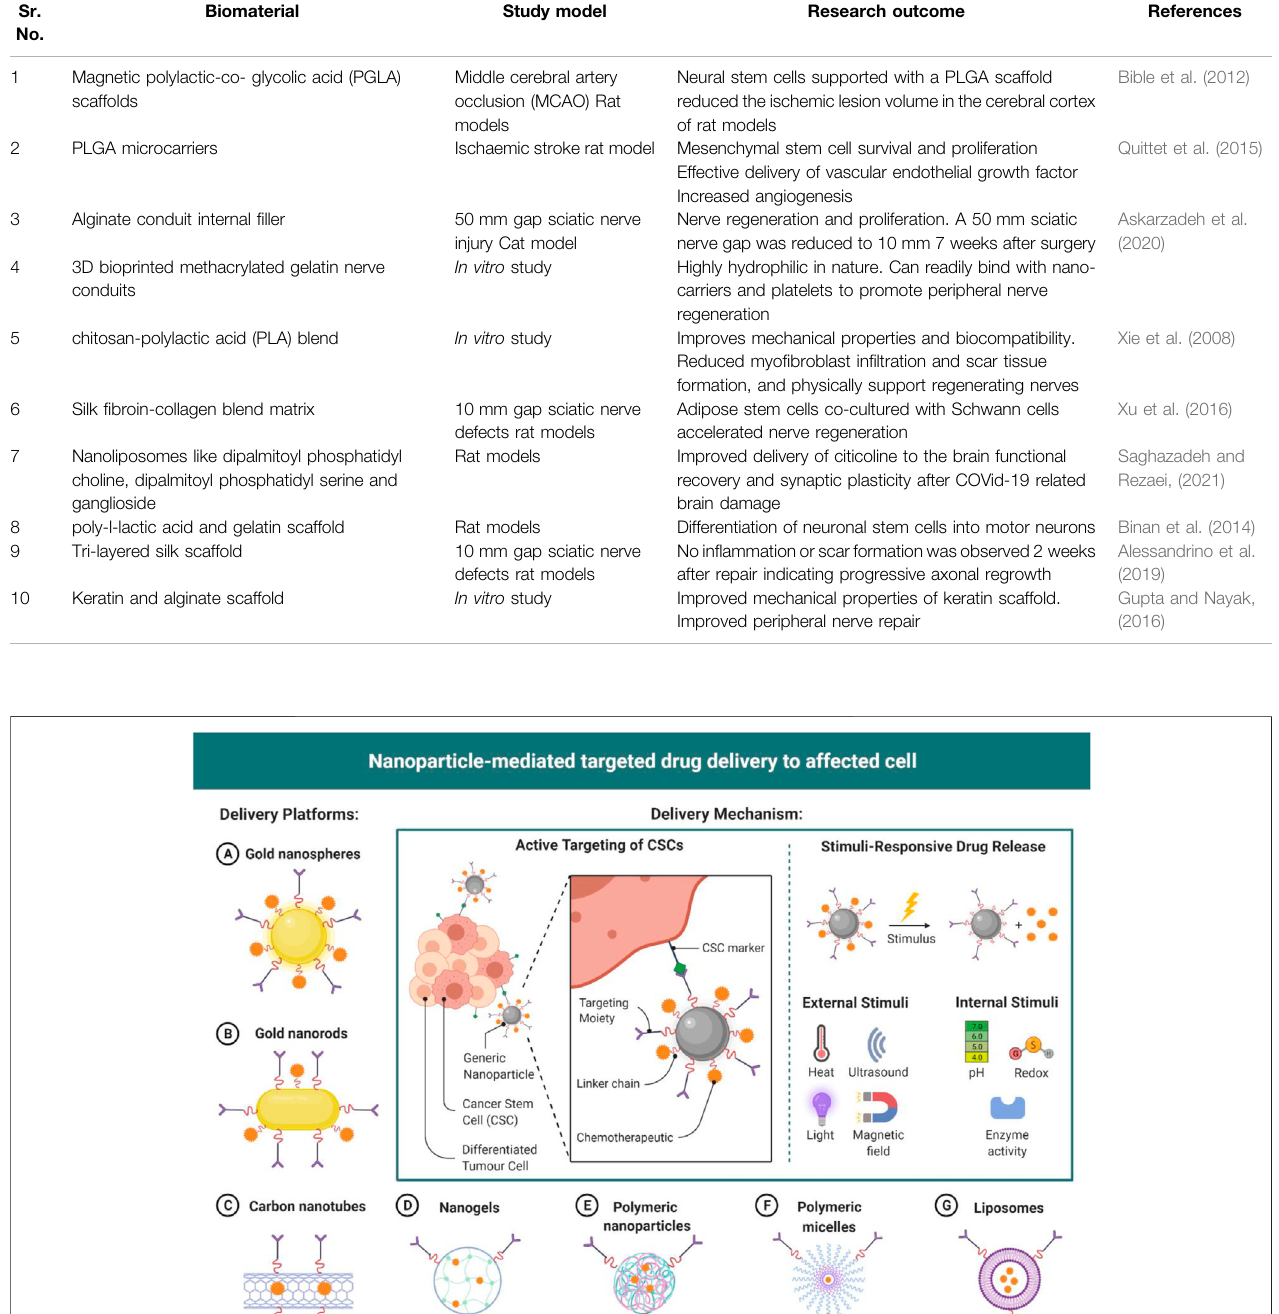
TABLE 2 | Advances in bio nanomaterial applications in neurological studies. Sr. No.